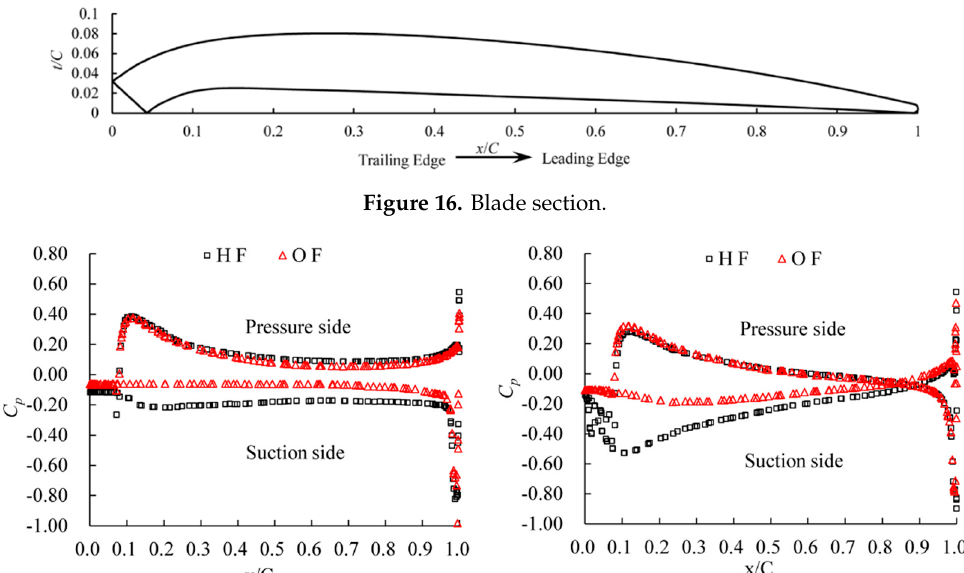
Figure 17. Pressure distribution at 0.7 R of No. 2 Blade ( left : J = 1.0; right : J = 1.4).